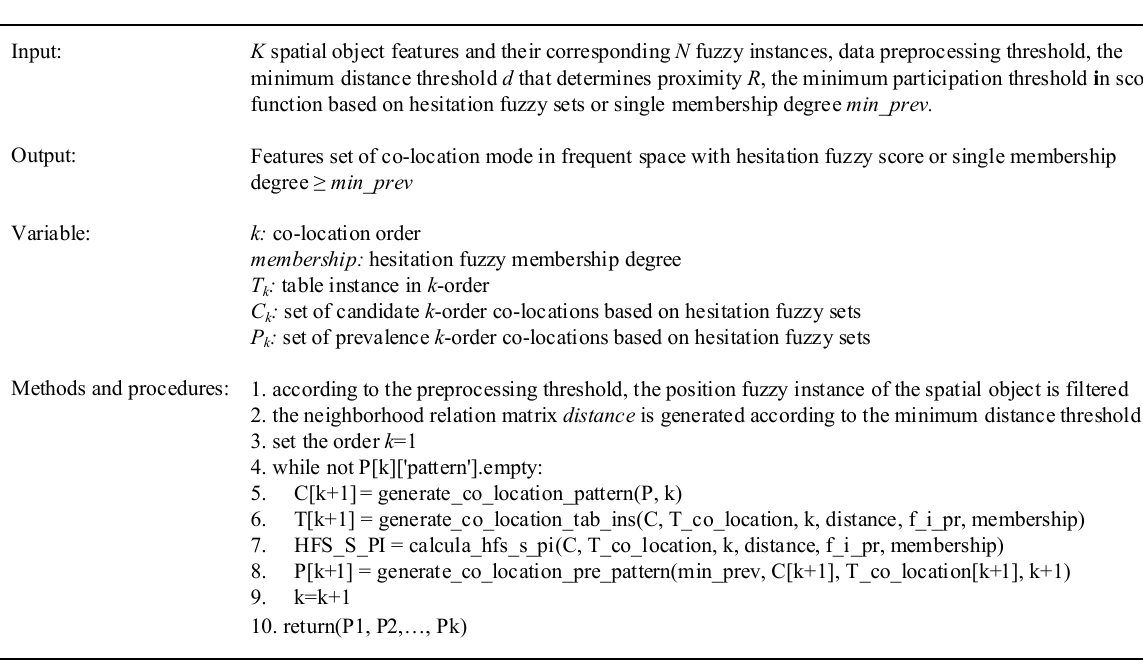
Figure 3. Spatial co-location pattern mining algorithm based on hesitant fuzzy